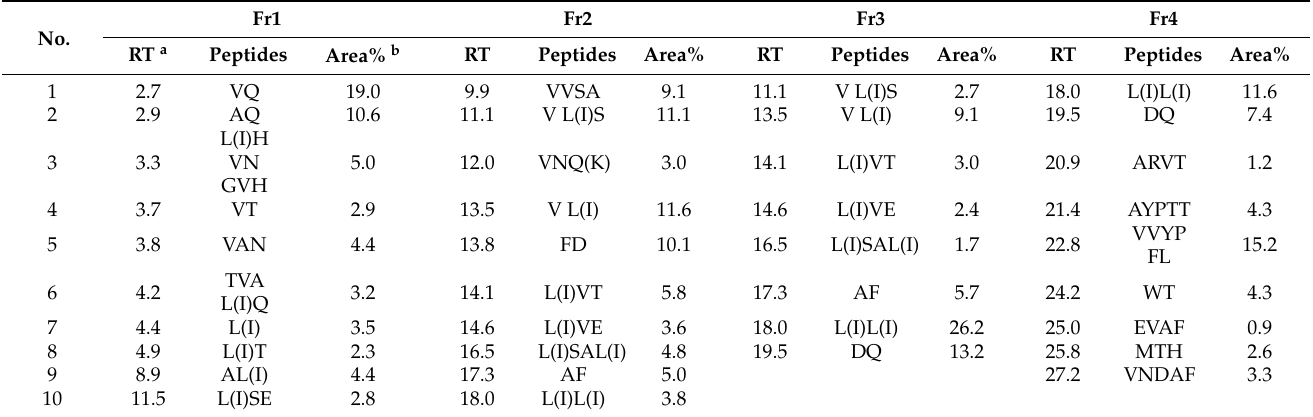
Table 2. Peptide structures.